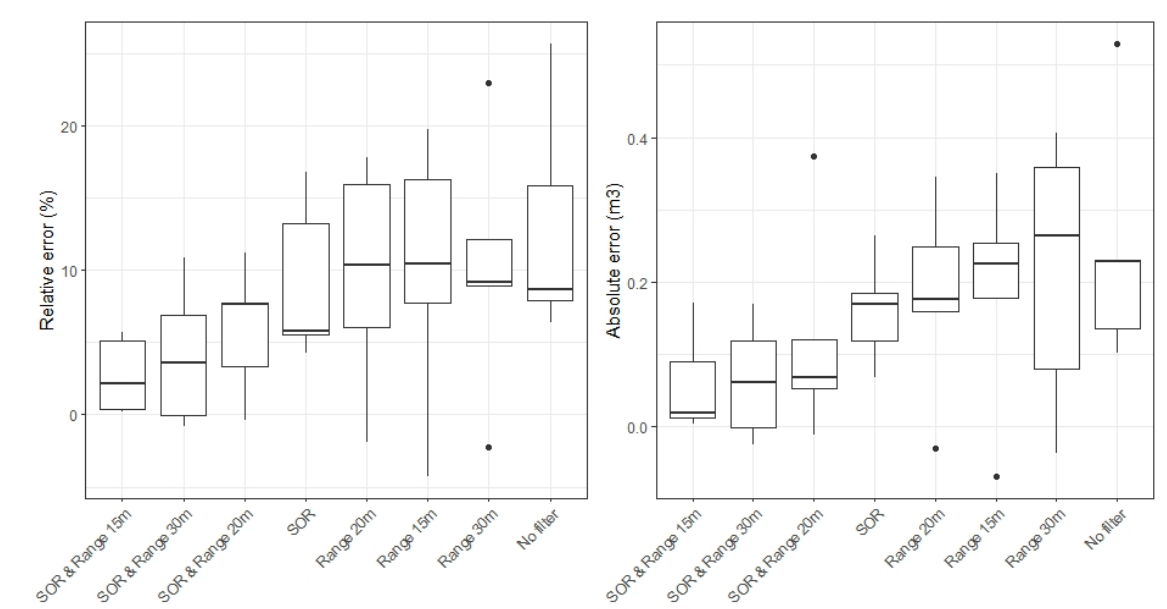
Figure A1. Relative (%) and absolute (m 3 ) merchantable wood volume error distribution of each filtering modality for five trees randomly chosen among the 26 trees.